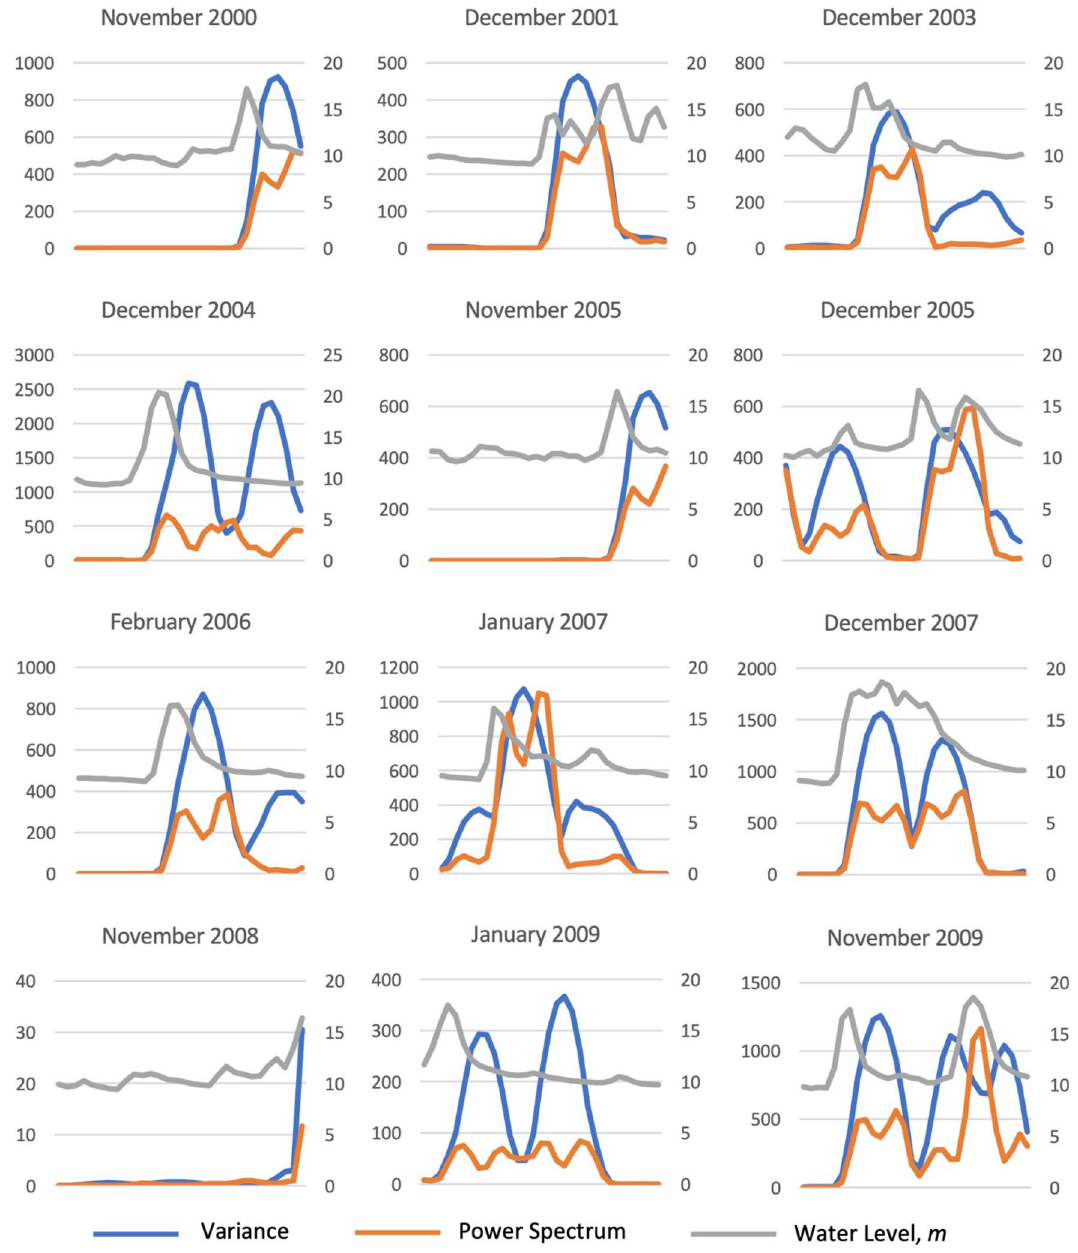
Figure 8. Trends of the time series of the CSD indicators (primary axis) variance and average spectral density at low frequencies and their respective water level time series (secondary axis) for all twelve flood events at Kelantan River from 01/01/2000 to